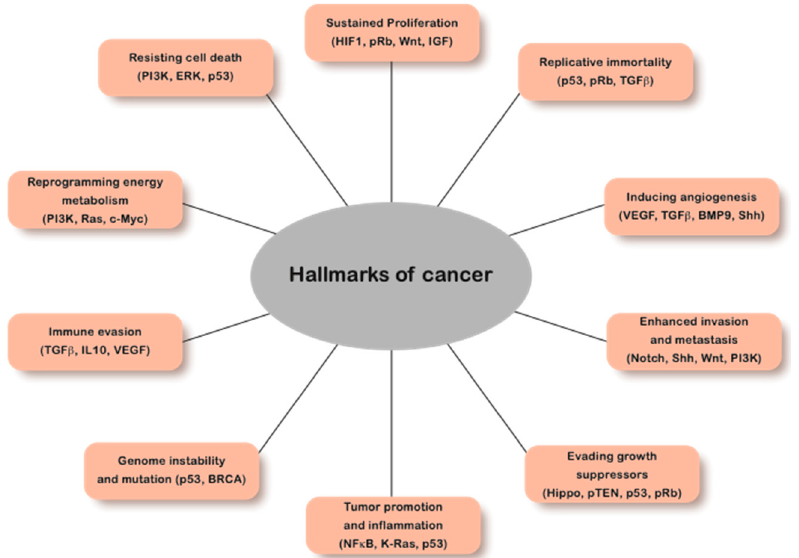
Figure 1. Hallmarks of cancer. A schematic representation of the pathways conferring growth advantage to tumor cells in different types of cancer. The prominent proteins of these pathways identified in patient samples are shown in brackets. Importantly, the tumor cells gain growth advantages through various mechanistic strategies and deregulated pathways. Source: [2–10].